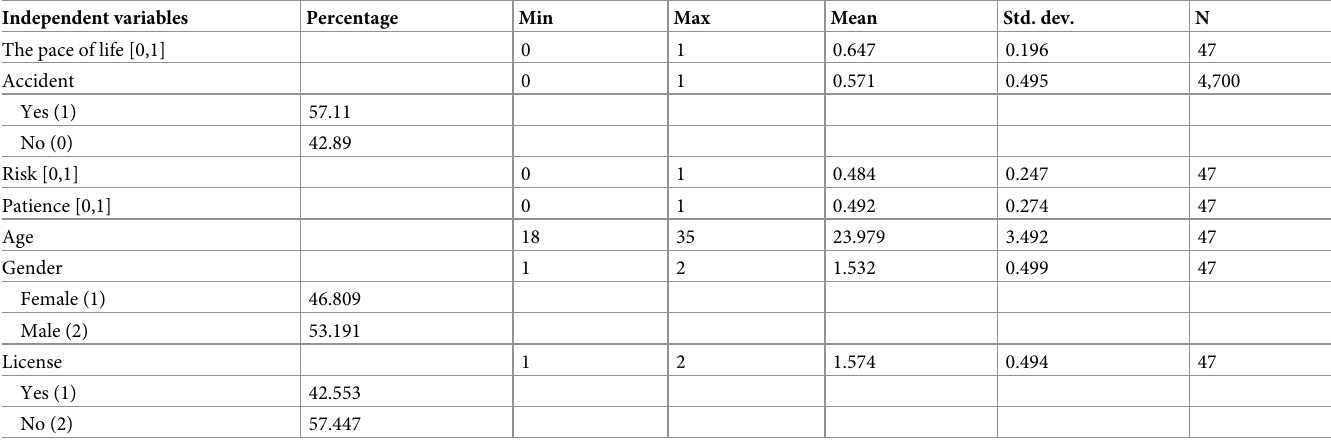
Table 3. Summary statistics of independent